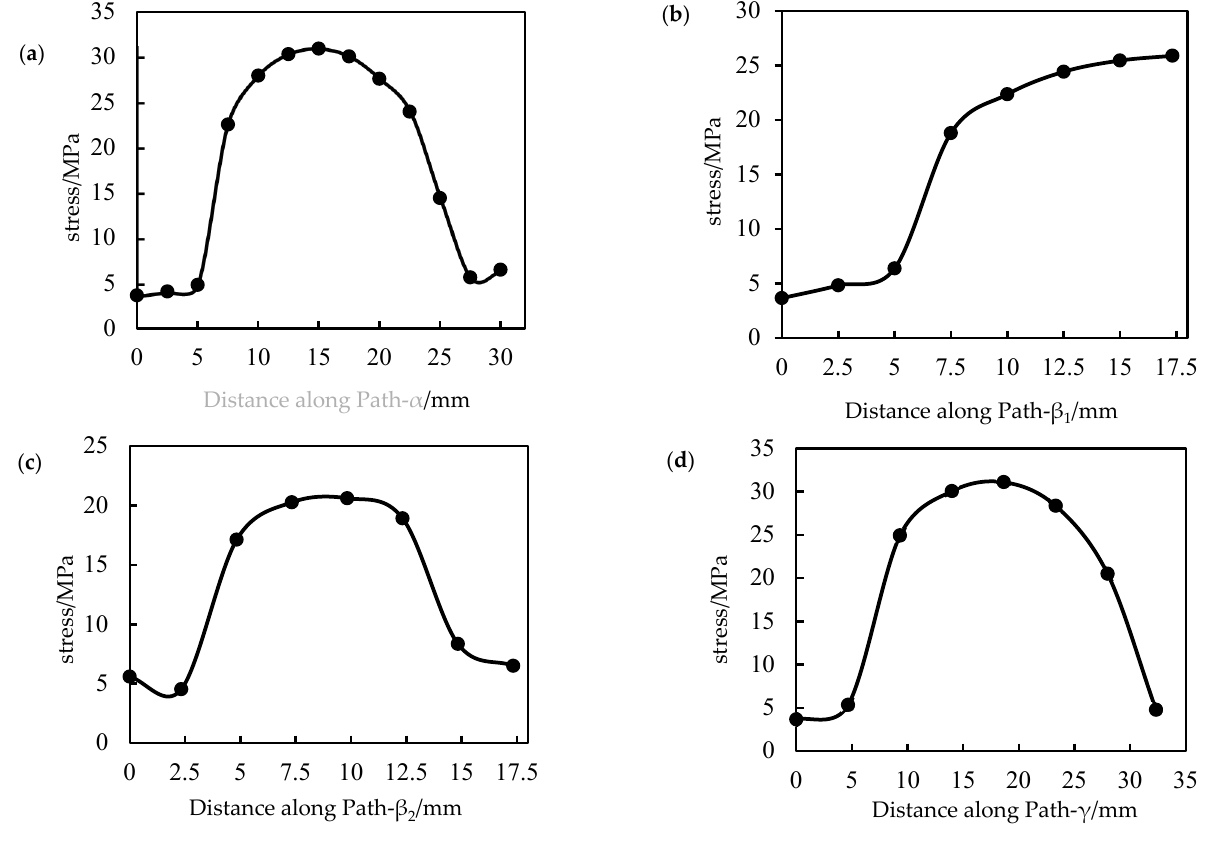
Figure 21. Distribution of stress of ribs along each path. ( a ) Path- α , ( b ) Path- β 1, ( c ) Path- β 2, ( d ) Path- γ .